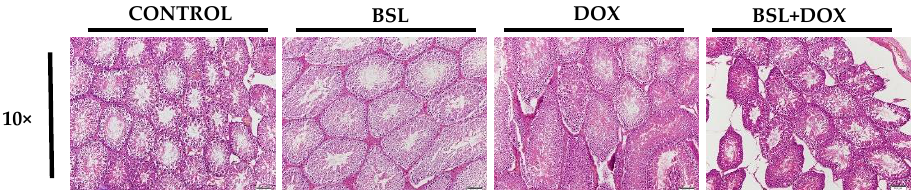
Figure 4. Histopathology of the testis. Testes of normal control rats and rats treated with α -bisabolol alone showed no pathological alterations. Rats treated with DOX alone showed severe derangement of testicular morphology, whereas α -bisabolol pre- and co-treatment reinstated the near normal testicular architecture in DOX-injected rats (10 × ), CON-Control, BSL- α -Bisabolol, DOX-Doxorubicin, BSL + DOX- α -Bisabolol +